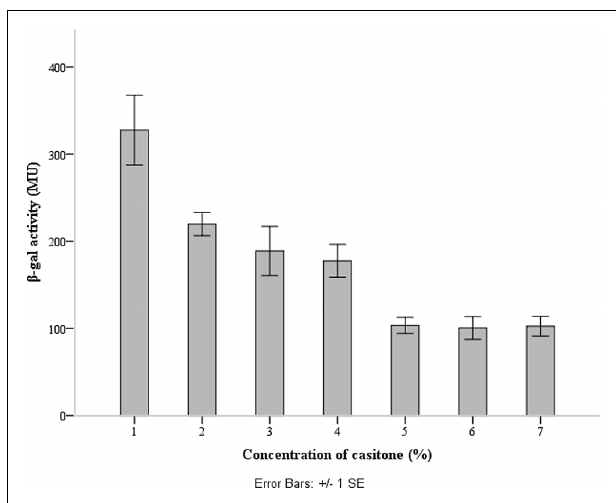
FIGURE 5 | lcnB promoter activity measured by β -galactosidase activity assay. When the cells grow in GM17 medium with a low concentration of casitone, β -galactosidase activity is approximately three times higher than in GM17 medium with a higher concentration of casitone.